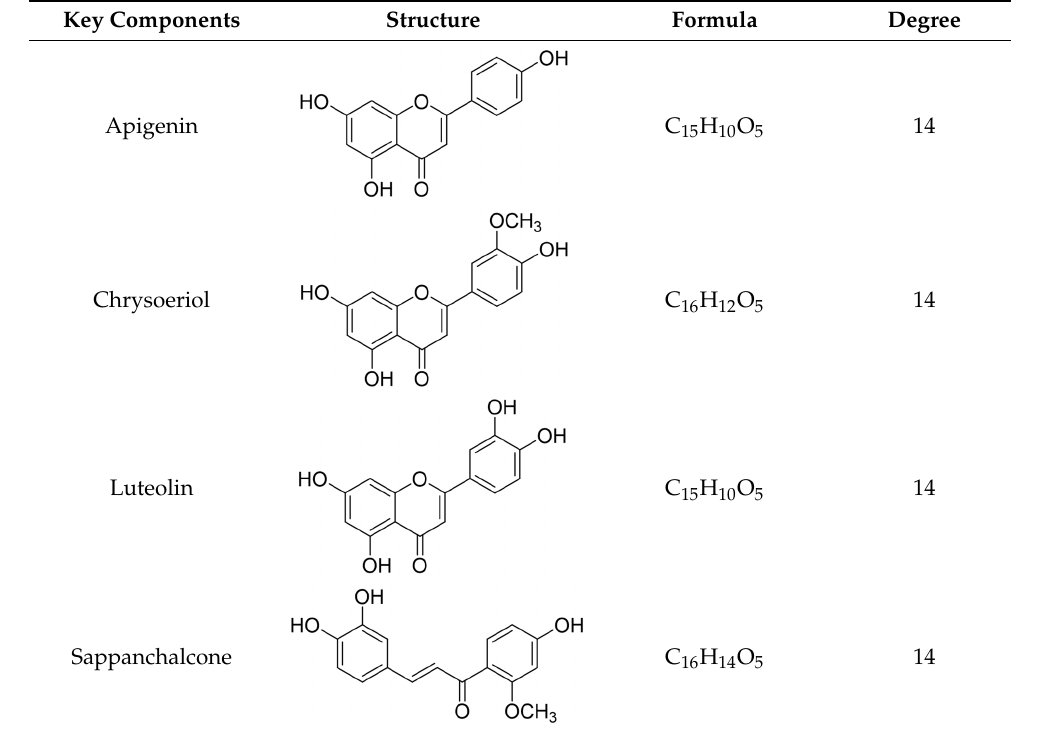
Figure 4. Integrated H-C-T-P network. Table 2. List of key components of Dangguisu-san from the H-C-T-P network analysis.